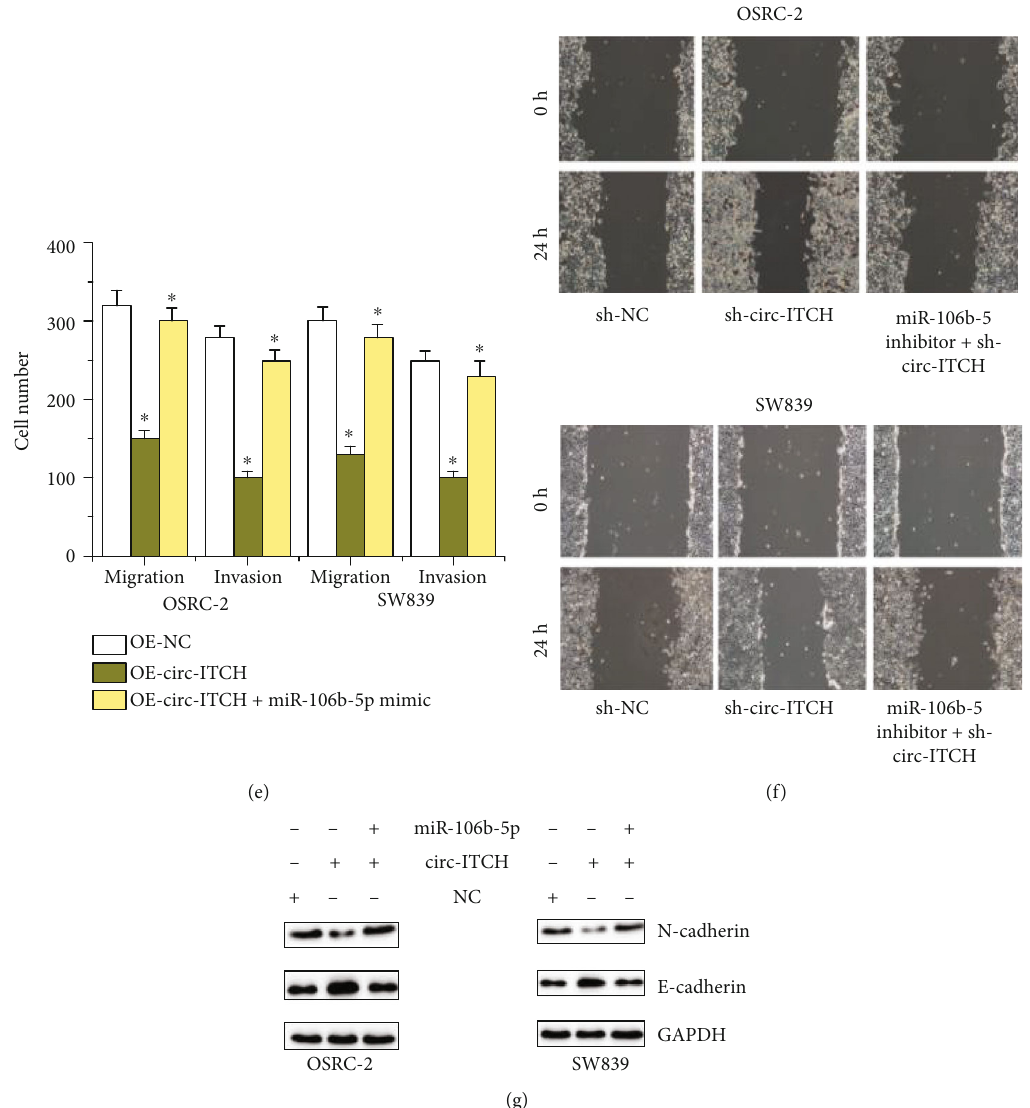
Figure 2: circ-ITCH inhibits ccRCC cell metastasis via sponging miR-106b-5p. (a) The predicted binding sites between circ-ITCH and miR- 106b-5p. (b) The dual luciferase reporter assay detects the luciferase activity of circ-ITCH-WT/circ-ITCH-MUT in OSRC-2 and SW839 cells cotransfected with miR-106b-5p mimics. (c) The expression of miR-106b-5p in ccRCC tissues. (d, e) Transwell assay detects migration and invasion abilities of OSRC-2 and SW839 cells transfected with OE-NC, OE-circ-ITCH, OE-circ-ITCH, and miR-106b-5p mimic. (f) Wound healing detects migration abilities of OSRC-2 and SW839 cells transfected with sh-NC, sh-circ-ITCH, and sh-circ-ITCH + miR-106b-5p inhibitor. (g) Western blot analyzes the expressions of E-cadherin, N-cadherin in OSRC-2, SW839 cells transfected with NC, OE-circ- ITCH, OE-circ-ITCH, and miR-106b-5p